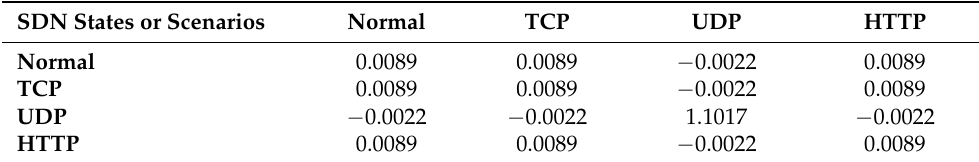
Table 6. Covariance matrix for J t when the SDN is operating normally and subjected to popular variants of DDoS flooding attacks.